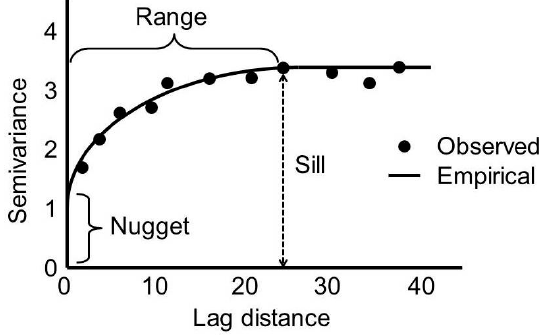
Figure 2. A typical example of semivariogram showing different components (Creative Commons [41]).